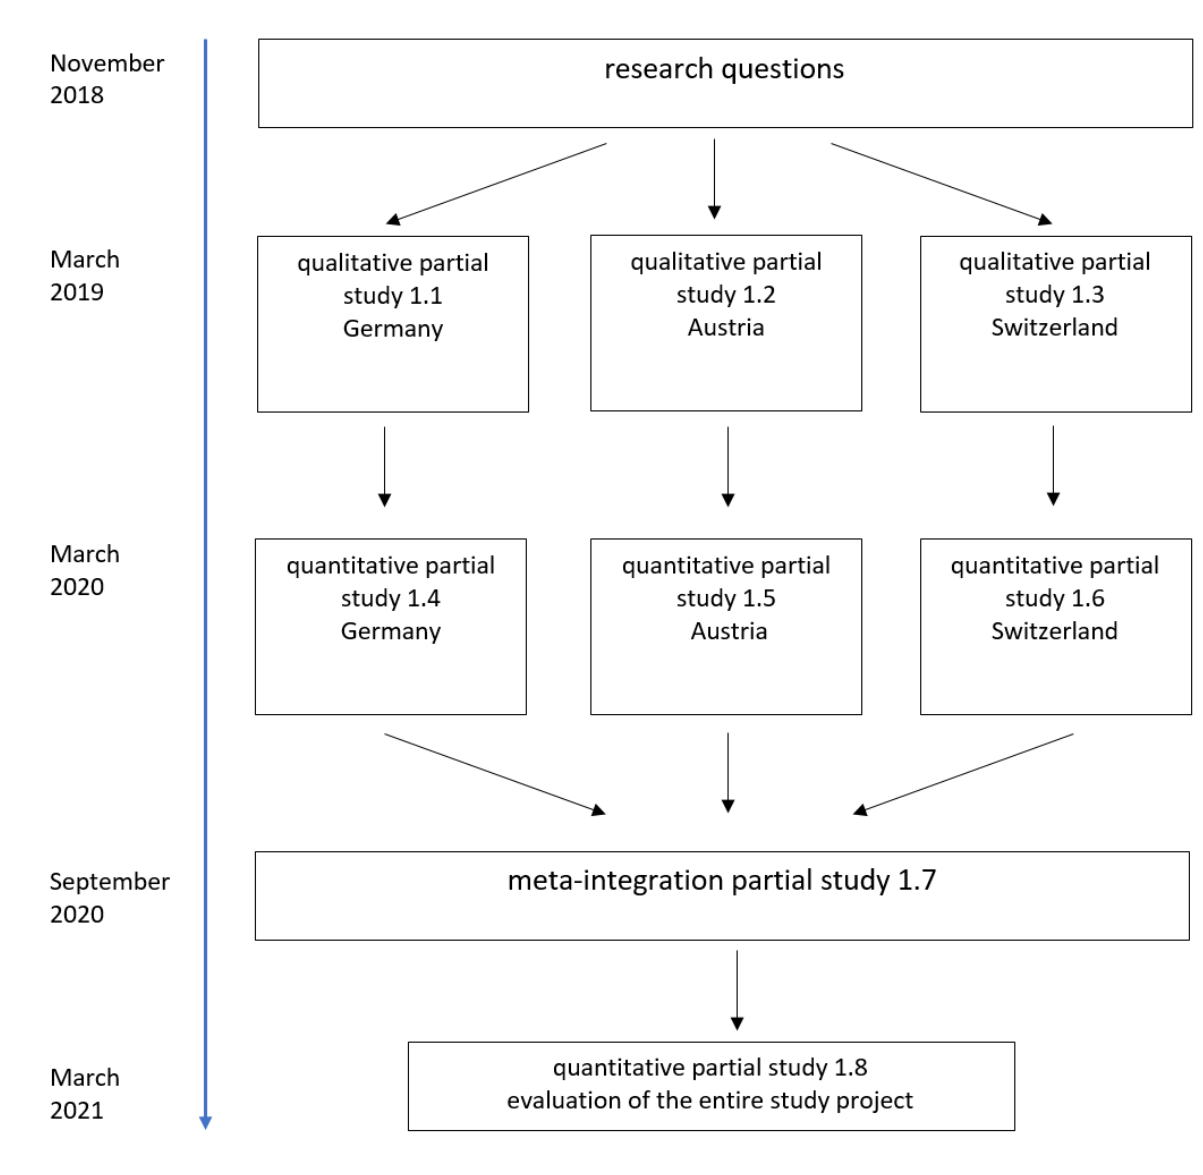
Figure 1. Design of the Characteristics, Opportunities, and Challenges of Osteopathy (COCO) study as a